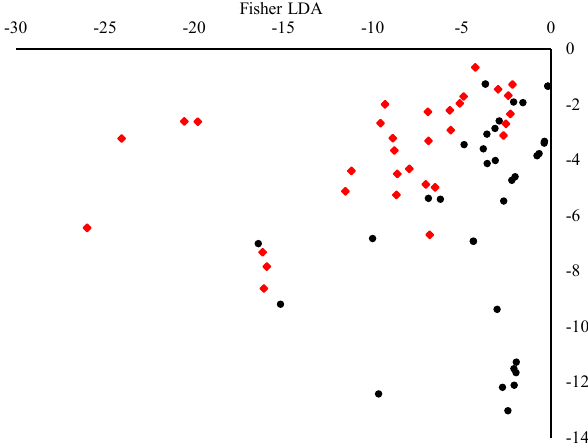
Figure 2 . Linear discriminant analysis biplot obtained using non-parametric Fisher type on mode 1 scores of the four-component PARAFAC model. (Black circles) EVOOs of Maltese origin and (red diamonds) EVOOs of non-Maltese origin